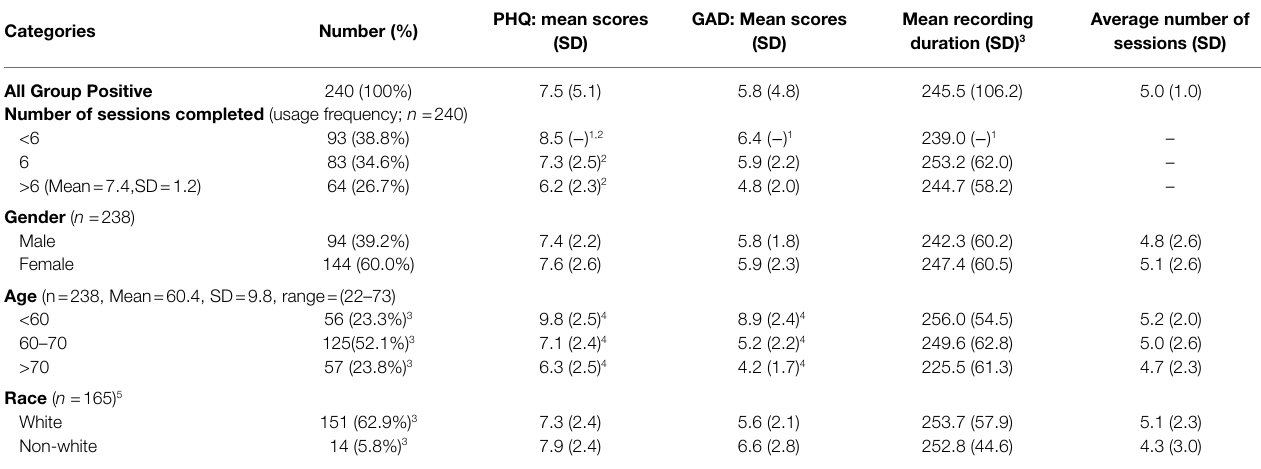
TABLE 6 | Demographics, initial PHQ/GAD scores, and session duration/average number for Group Positive